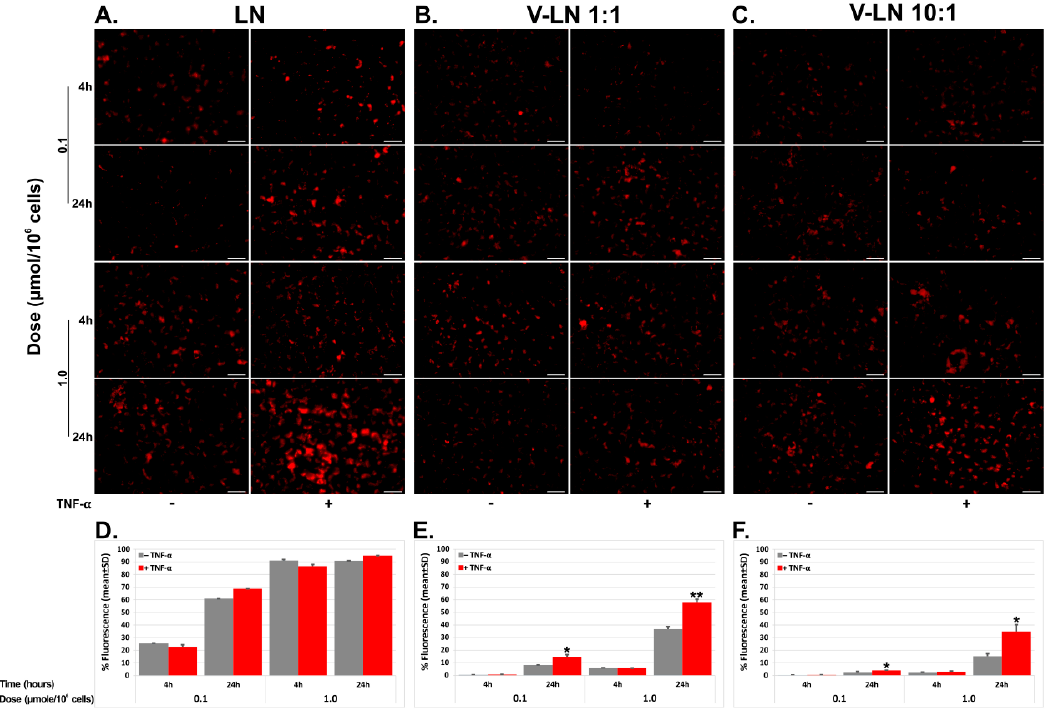
Figure Figure 4. Uptake of Rhodamine-labelled non-targeted ( A , D ) or VCAM-1 targeted ( B , C , E , F ) nanoparticles by EA.hy926 cells. Confluent endothelial cells EA.hy926 activated or not with Tumor Necrosis Factor (TNF)- α (20 ng/mL) for 18 h were incubated for the indicated times with two different